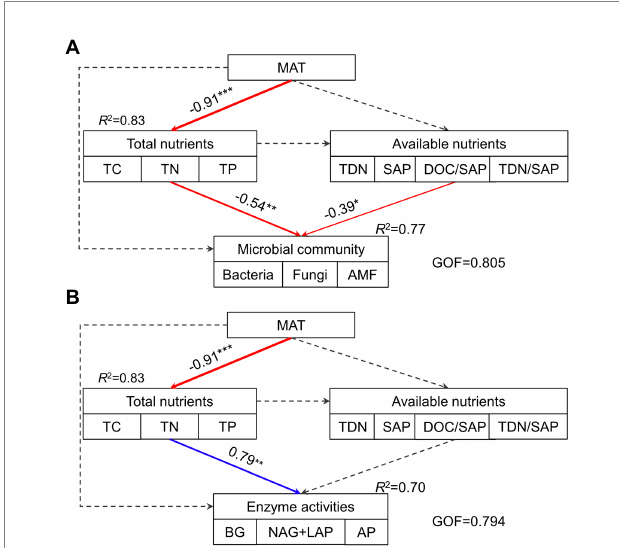
FIGURE 5 The path model describing the direct and indirect effects of MAT, soil total nutrients and available nutrients on soil microbial community (A) and extracellular enzyme activities (B) . Continuous arrows indicate significant relationships with blue representing positive effects and red representing negative effects, while dashed arrows indicate nonsignificant relationships. The width of arrows characterizes the strength of path coefficients. R 2 values indicate the proportion of variance explained. GOF, goodness of fit; MAT, mean annual temperature; TC, total carbon; TN, total nitrogen; TP, total phosphorus; TDN, total dissolved N; SAP, available P; DOC/SAP, the ratio of DOC to SAP; TDN/SAP, the ratio of TDN to SAP.